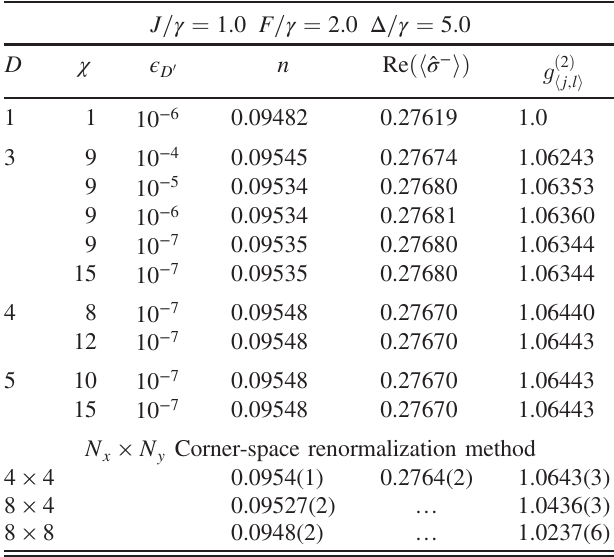
TABLE I. Steady-state values of a hard-core boson model on an infinite square lattice with parameters Δ = γ ¼ 5 . 0 , F= γ ¼ 2 . 0 , and J= γ ¼ 1 . 0 calculated using FET þ WTG. In each case, we use a time step of τγ ¼ 0 . 0025 . For comparison, we tabulate results for the same parameters from the corner-space renormalization method [56] for different sizes N × N . x y